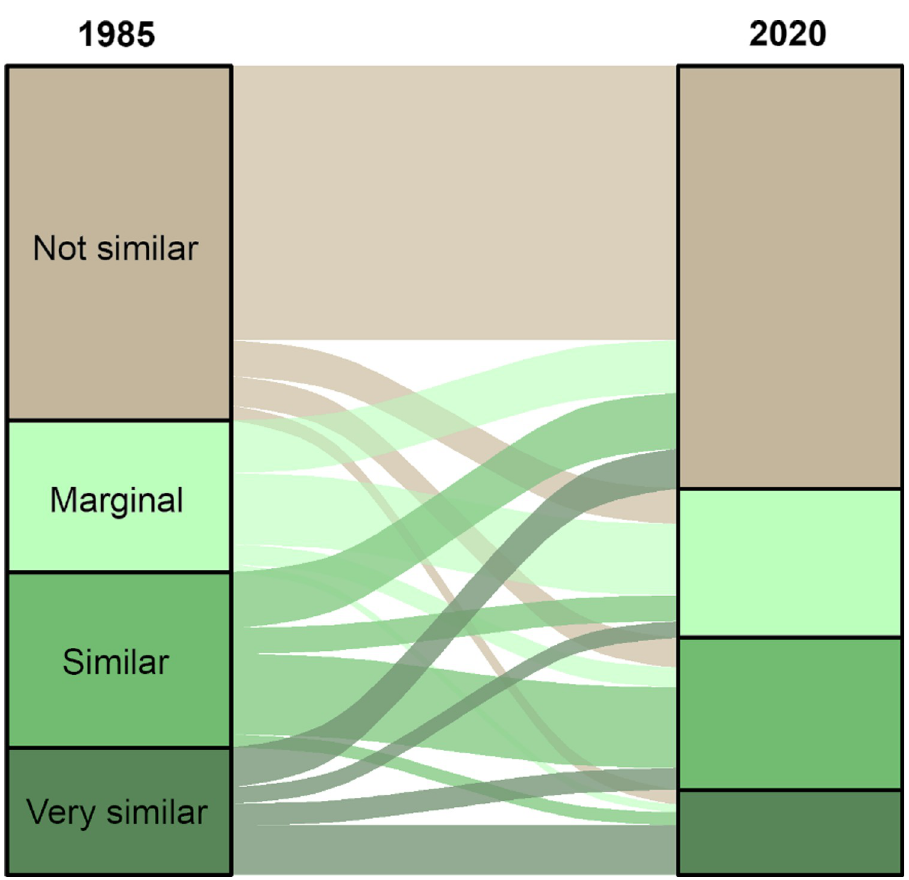
Fig 8. Sankey diagram showing flow of cover type spectral similarity classes between 1985 and 2020. The height of each segment (left and right columns) or flow (connections between columns) is proportional to the total land area in each class. Flows show changes in the spectral similarity class of classified pixels between the two time periods. Values were square root transformed to improve visualization.